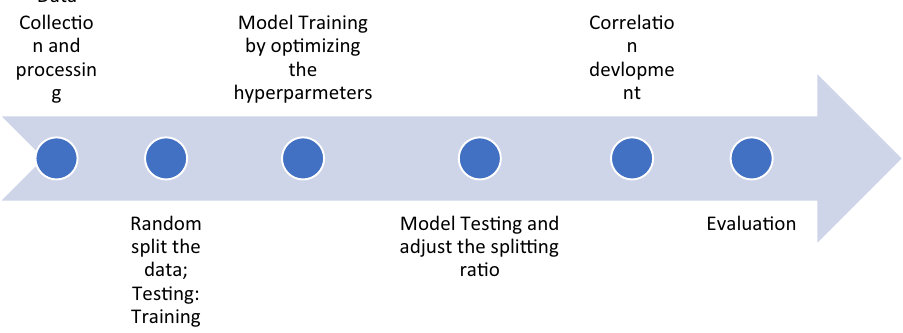
Model Tes(cid:26)ng and adjust the spli(cid:2)ng ra(cid:26)o